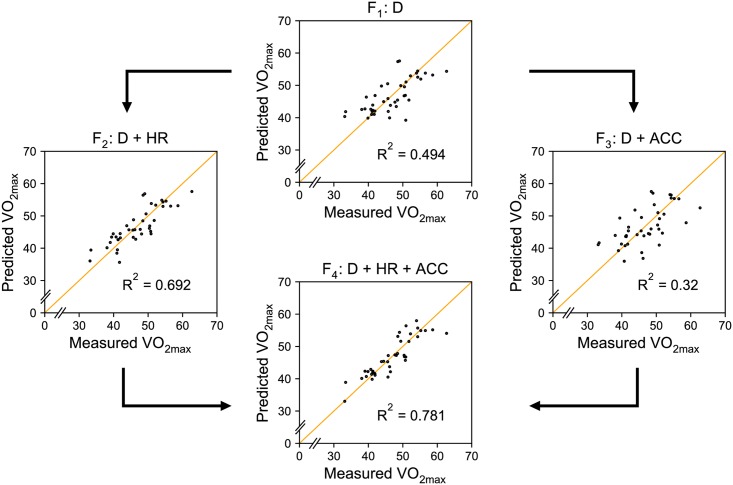
Calculation of contact time from the vertical lower back acceleration.The green and red dots indicate respectively starts and ends of foot-ground contact.